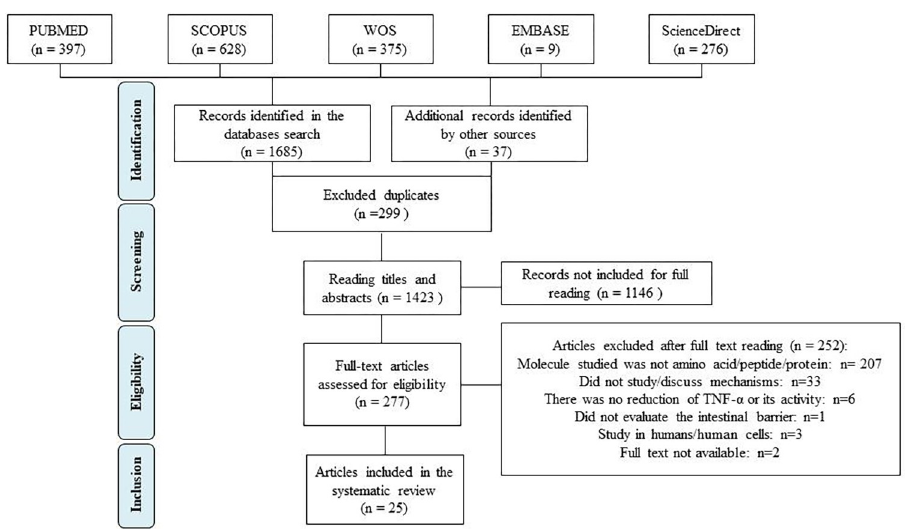
Fig 1. PRISMA flow diagram. Preferred Reporting Items for Systematic Reviews and Meta-Analyses Protocols (PRISMA-P) flowchart [13] of the articles included in the systematic review, aiming to answer the question: what are the mechanisms of action of molecules with anti-tnf- α activity on the intestinal barrier?